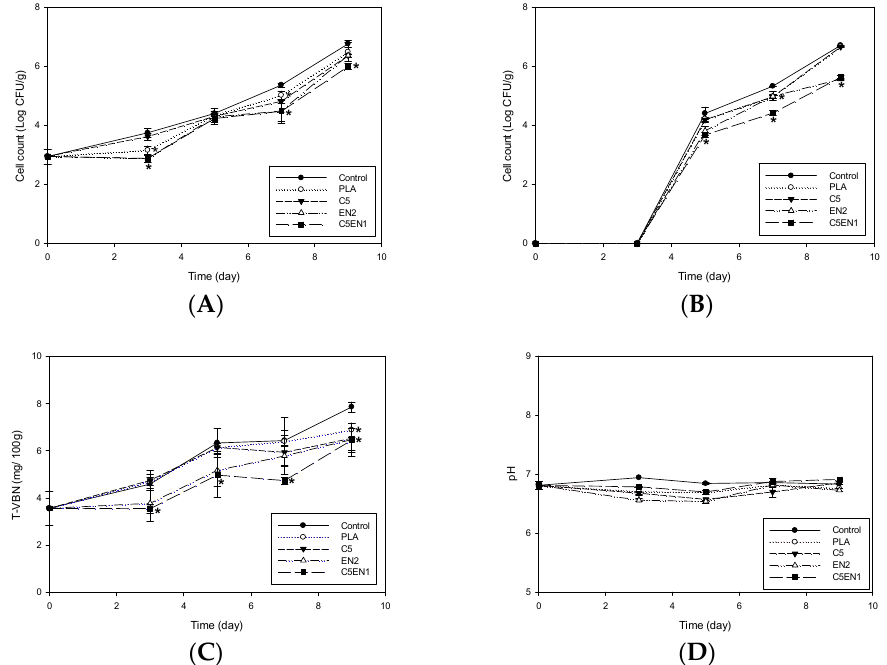
Figure 6. Changes in mesophilic count ( A ), psychrotrophic count ( B ), TVBN content ( C ) and pH value ( D ) of fish fillet ( Epinephelus fuscoguttatus × Epinephelus lanceolatus ) covered with PLA, C5, EN2, or C5EN1 film during storage at 4 °C. PLA, PLA film as control; C5, PLA + 0.5% chitosan; EN2, PLA + 20 mM EDTA + 0.02% nisin; C5EN1, PLA + 0.5%chitosan + 20 mM EDTA + 0.01% nisin. Data are presented as mean ± SD (n = 3). * means significantly different, compared to control ( p < 0.05). The changes in cell counts of special microbial groups of Escherichia (A), Aeromonas (B), Pseudomonas (C), and Vibrio (D) in fish fillets covered by the PLA, C5, EN2, or C5EN1